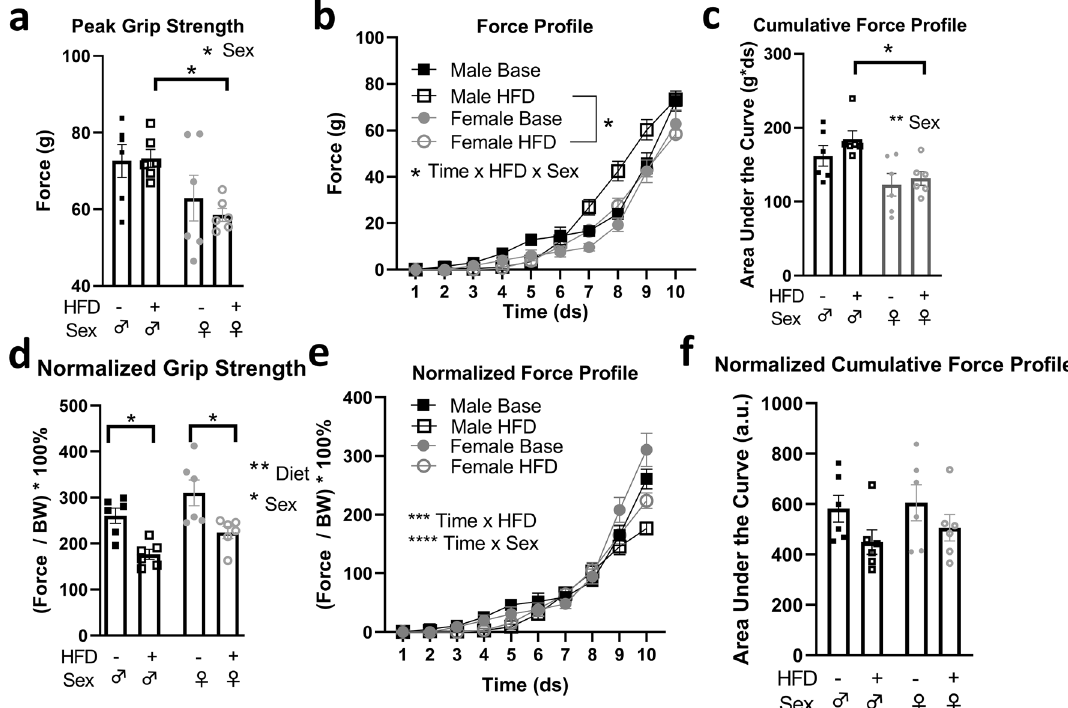
Figure 5. Sex differences in diet-induced alterations in muscle strength. ( a , b ) Females have reduced peak grip strength following high fat diet (HFD) exposure. Males have a HFD-induced increase in force profile (*p < 0.05, time × HFD × sex interaction, Tukey’s post-hoc multiple comparison, three-way, repeated measures ANOVA; n = 6/group). ( c ) Males exposed to HFD have significantly greater cumulative force profile compared to females. (*p < 0.05, **p < 0.01, effect of sex, two-way repeated-measures ANOVA, Sidak post-hoc test). ( d ) Peak grip strength normalized to body weight is reduced in both sexes following HFD exposure (* p < 0.05, Two-way, repeated measures ANOVA). ( e ) Normalized force profile, but not ( f ) normalized cumulative force profile, is reduced by HFD (***p < 0.001, time × HFD interaction; ****p < 0.0001, time × sex interaction; three-way, repeated-measures